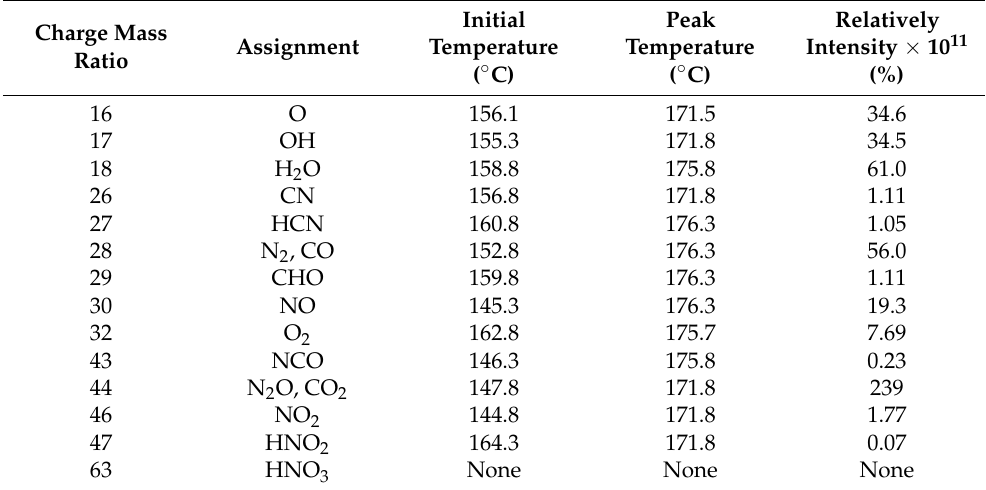
Table 6. Fragments and assignments of the thermal decomposition products of NC/ADN mixture. Charge Mass Ratio